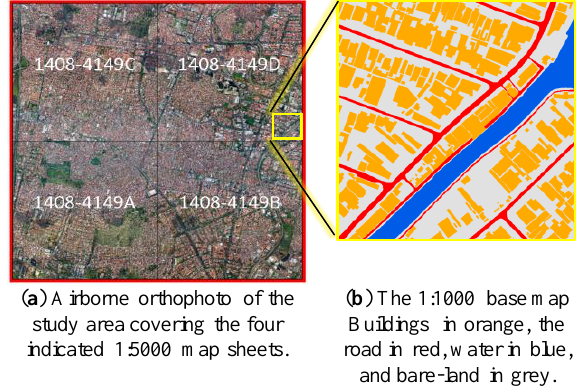
Figure 1. The study area in the city of Surabaya, Indonesia.